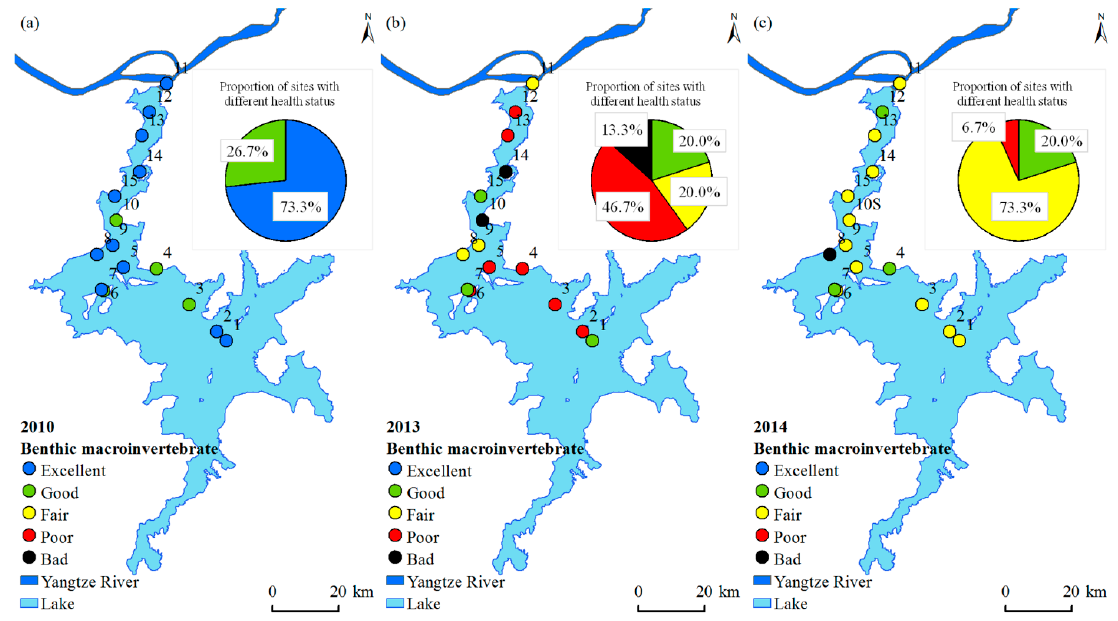
Figure 8. Health status of benthic macroinvertebrate at the sample sites in Lake Poyang in 2010 ( a ), 2013 ( b ) and 2014 ( c ).